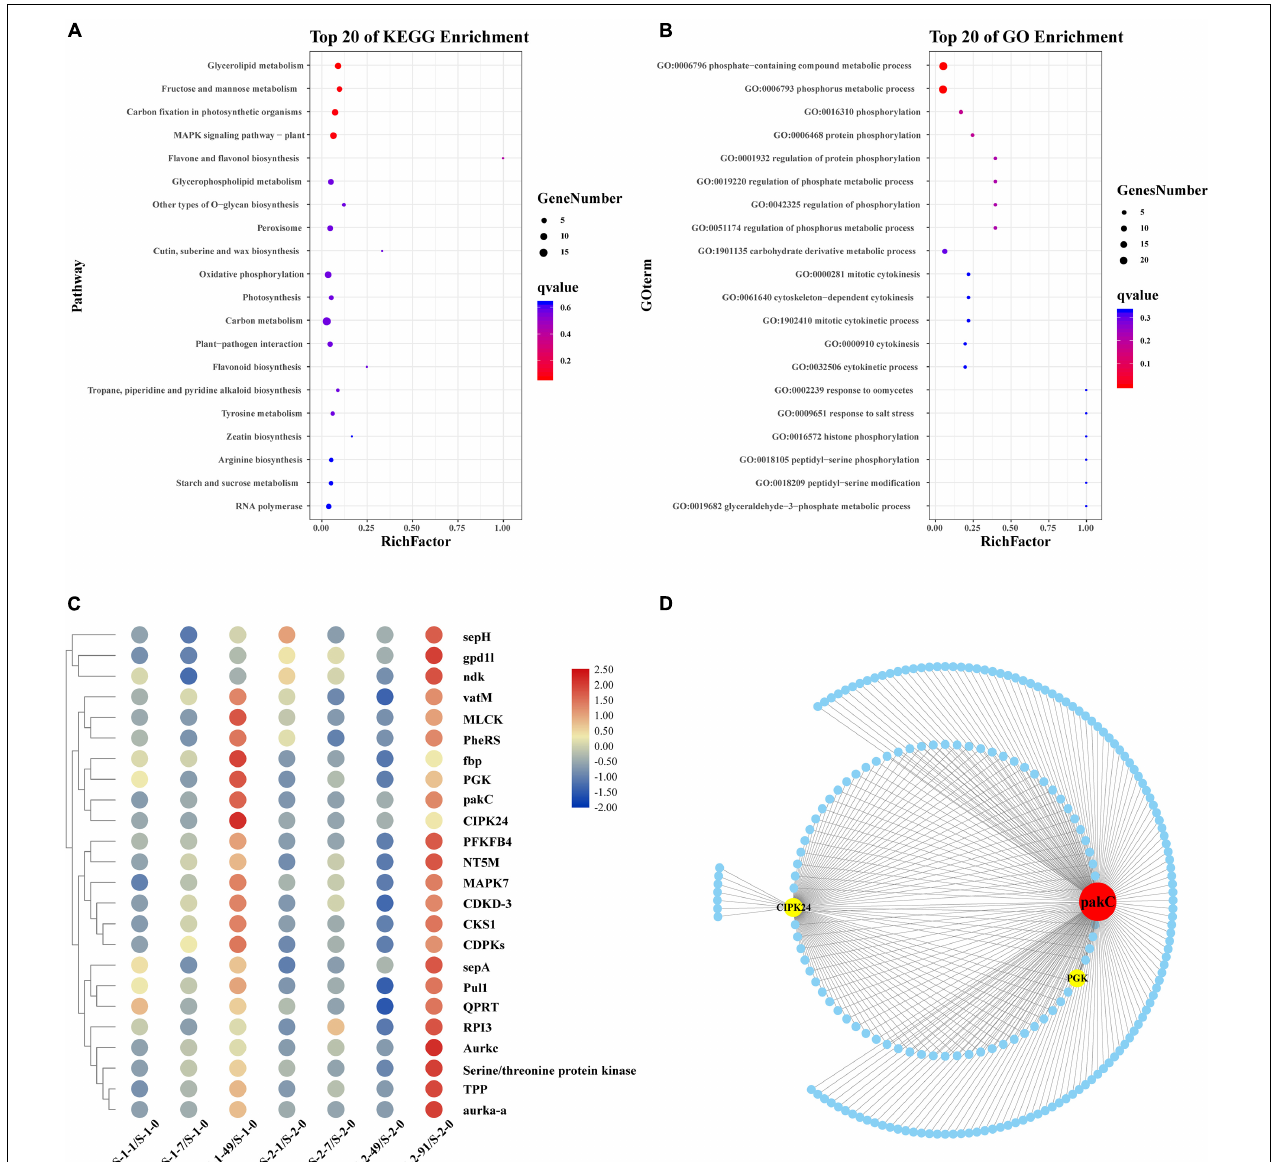
FIGURE 3 | Functional enrichment analysis and network construction of yellow module obtained by WGCNA. (A) Top 20 KEGG pathways enriched with unigenes in yellow module. Enriched pathways with P < 0.05 are marked with a red dot. (B) Gene Ontology (GO) categories enriched with genes in yellow module. Red dots indicate those pathways with P < 0.05. (C) Hierarchical clustering of genes related to phosphorus metabolism in yellow module. Red: upregulation; Blue: downregulation. Transcript levels of genes are shown as -fold changes in RPKM compared with that at S-1-0 or S-2-0. sepH, cytokinesis protein; gpd1l, glycerol-3-phosphate dehydrogenase; ndk, nucleoside diphosphate kinase; vatM, vacuolar proton ATPase; MLCK, myosin light chain kinase; PheRS, phenylalanyl-tRNA synthetase; fbp, inositol phosphatase/fructose-16-bisphosphatase; PGK, phosphoglycerate kinase; pakC, p21-activated protein kinase; CIPK24, CBL-interacting protein kinase 24; PFKFB4, 6-phosphofructo-2-kinase/fructose-2, 6-biphosphatase 4; NT5M, 5 (3)-deoxyribonucleotidase; MAPK7, mitogen-activated protein kinase 7; CDKD-3, cyclin-dependent kinase D-3; CKS1, cyclin-dependent kinase; CDPKs, calcium-dependent protein kinase; sepA. serine protease autotransporter; Pull, pullulanase; QPRT, nicotinate-nucleotide pyrophosphorylase; RPI3, ribose-5-phosphate isomerase; Aurkc, aurora kinase C; Tpp, tyrosine-protein phosphatase; aurka-a, aurora kinase. (D) Sub-network for hub genes in phosphorus metabolism and candidate hub-interacting genes. Sub-network was built by extracting hub genes and candidate co-expressed genes were those connected to more than one hub gene in phosphorus metabolism. pakC, p21-activated protein kinase; CIPK24, CBL-interacting protein kinase 24; PGK, phosphoglycerate